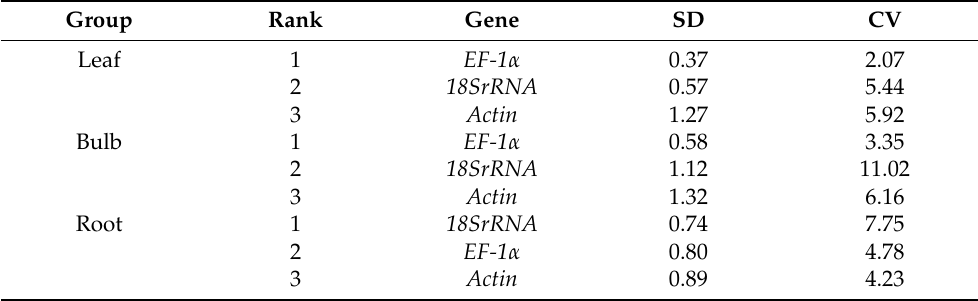
Figure 7. Transcription levels of GGT1 , GGT2 , GGT3 , PCS1 , FMO1 , and ALN detected by qRT-PCR and RNA-seq counts. Left y -axis, relative transcription level modified by Actin in qRT-PCR; right y -axis, transcription level quantified by fragments per kilobase of transcript per million mapped fragments (FPKM). The bar represents SE of the mean. Table 4. Stability comparison of the candidate genes analyzed and ranked by BestKeeper.